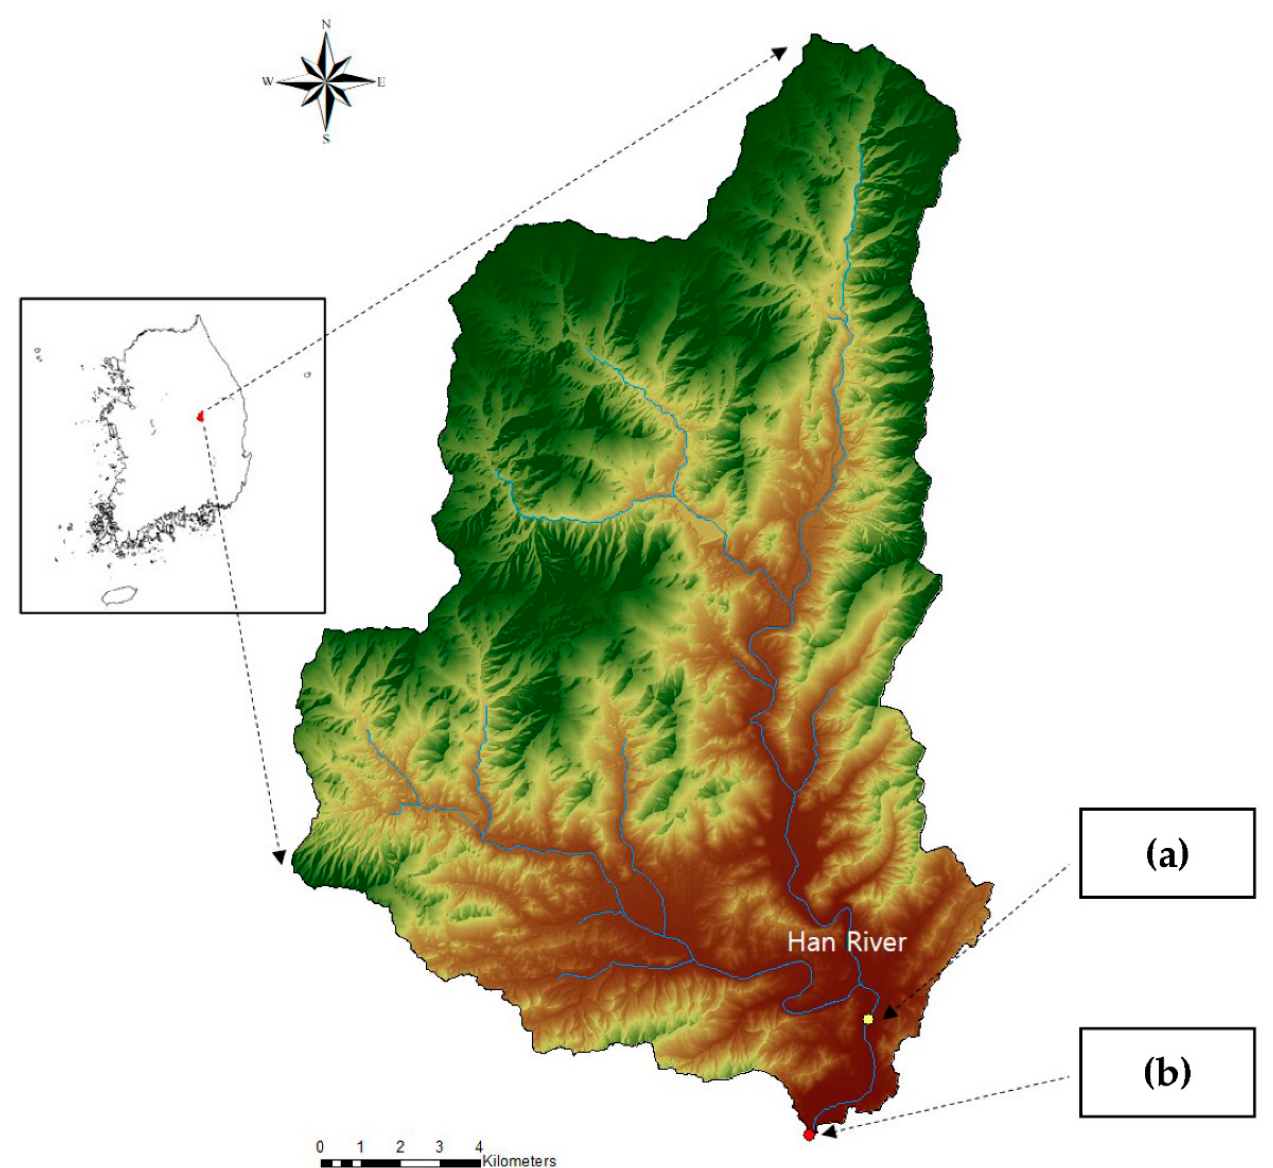
Figure 4. Geographic Information System (GIS) map of the study’s watershed of interest (Yecheon Water Intake Station); ( a ) ungauged Yecheon Water Intake Station, and ( b ) Yecheon Bridge, Soil and Water Assessment Tool (SWAT) calibration point with gauged daily water level. Table 1. Result weather information construction of Yecheon Basin